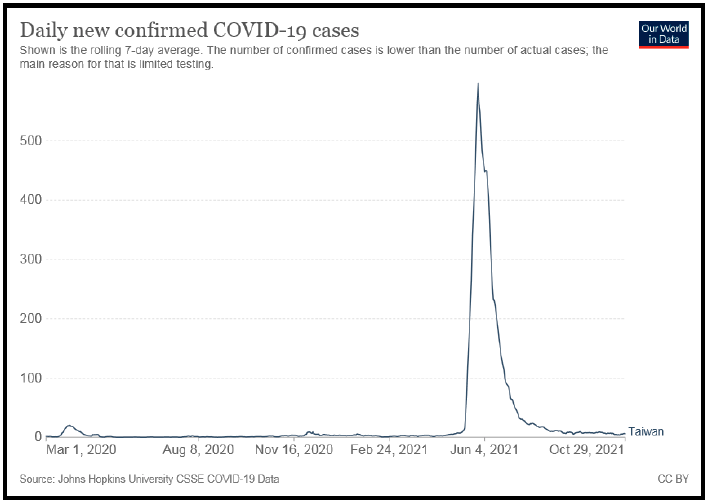
Figure 1. 7-day average confirmed COVID-19 cases in Taiwan [23].